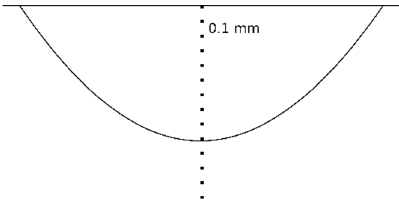
Figure 2. The Vickers hardness measurements scheme.